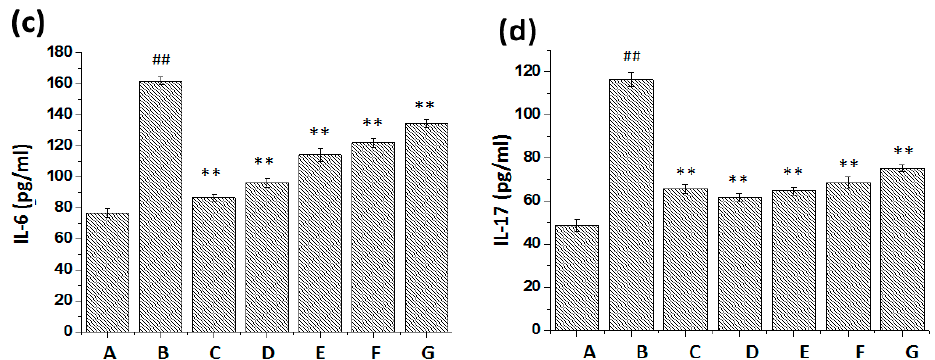
Figure 6. Effect of m KG on the content of TGF- β 1, HYP, IL-6 and IL-17 in the lung tissues of BLM-induced pulmonary fibrosis mice by ELISA analysis. ( a ) TGF- β 1 content in the lung tissues were detected by ELISA; ( b ) Hydroxyproline content in the lung tissues were detected by ELISA; ( c ) IL-6 content in the lung tissues were detected by ELISA; ( d ) IL-17 content in the lung tissues were detected by ELISA. Data were expressed as mean ± S.D. ## p < 0.01 compared with the control group. * p < 0.05, ** p < 0.01 compared with the BLM group. (A) Normal group; (B) BLM group; (C) Pirfenidone group; (D) Dexamethasone group; (E) m KG-H group; (F) m KG-M group; (G) m KG-L group.